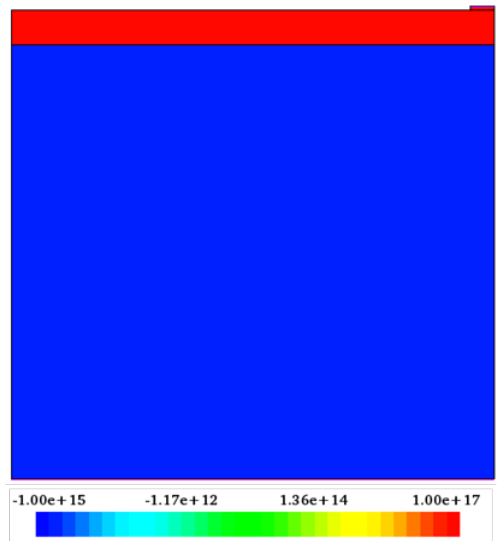
Figure 2. Geometrical model of MoO 3 /Si heterojunction solar cell.